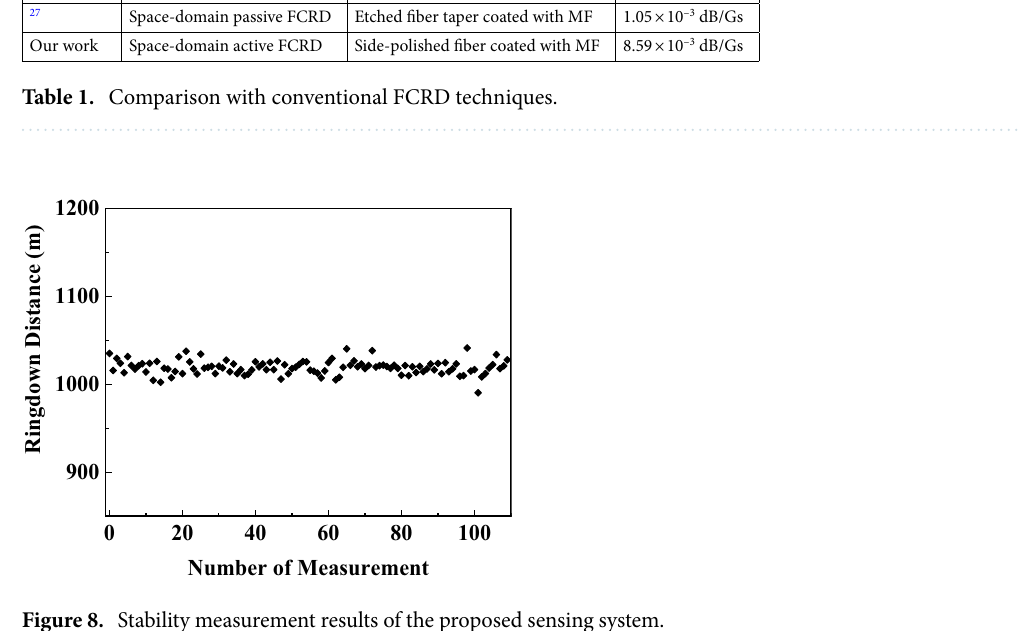
Figure 8. Stability measurement results of the proposed sensing